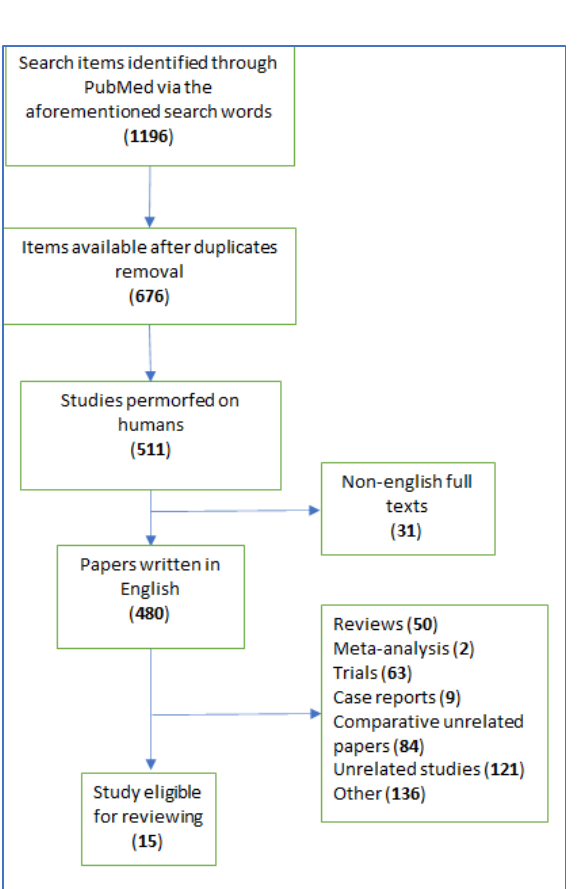
Figure 1. PRISMA flow-chart. Table 1. A summary of studies that compared BSGI and MRI. Table 2. A collection of papers in which BSGI was compared to